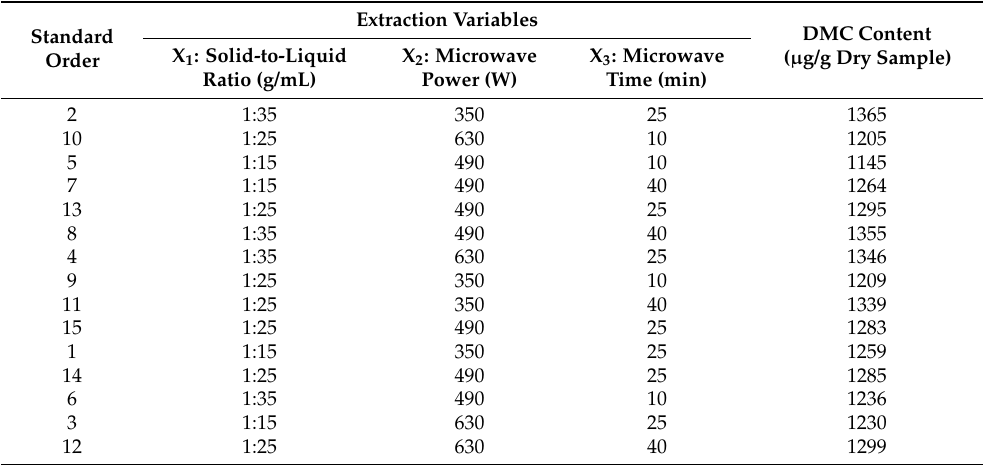
each variable with their observed